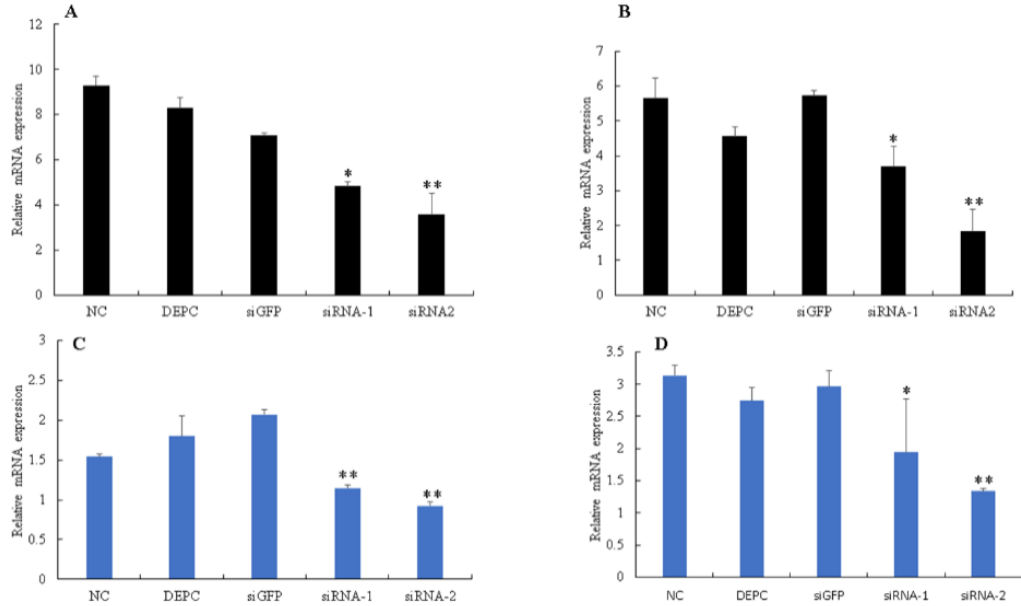
Figure 8. RNAi efficiency estimation of Bmserpin2 . The expression level of Bmserpin2 in haemocytes and the fat body was measured at 24 h and 48 h. Haemocytes ( A , B ); Fat body ( C , D ) after injection of siRNAs by qRT-PCR. NC: Negative control, DEPC: diethyl pyrocarbonate (DEPC) water, siGFP: si green fluorescent protein, siRNA-1: first target sequence of Bmserpin2 knockdown, siRNA-2: Second target sequence of Bmserpin2 knockdown. Statistical analysis was performed using SPSS software. Significant differences are indicated by * ( p < 0.05) or ** ( p < 0.01).